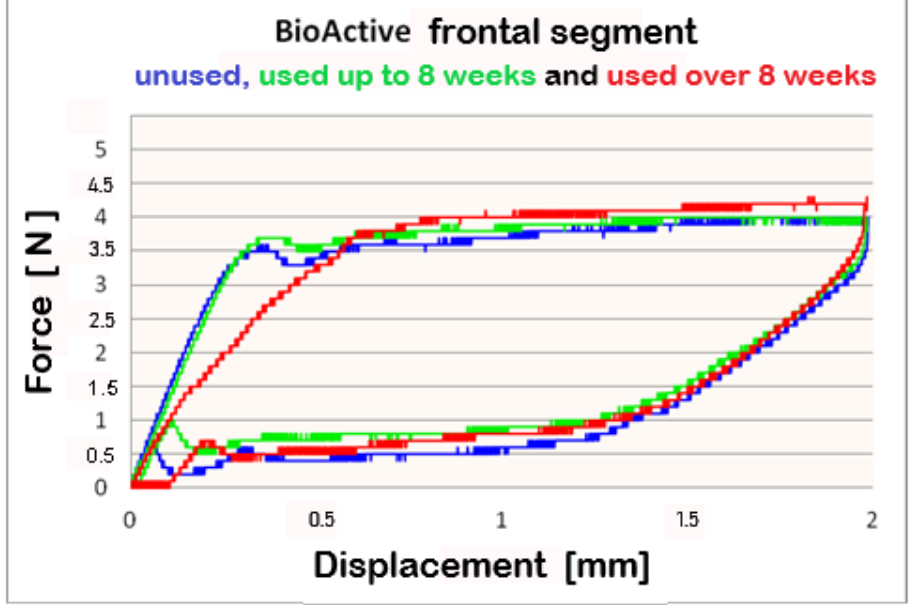
Figure 2. Combined force/deformation curve graphs for period G 0 (blue), G 1 (green) , G 2 (red), frontal segment for the Bio-Active ® archwire.